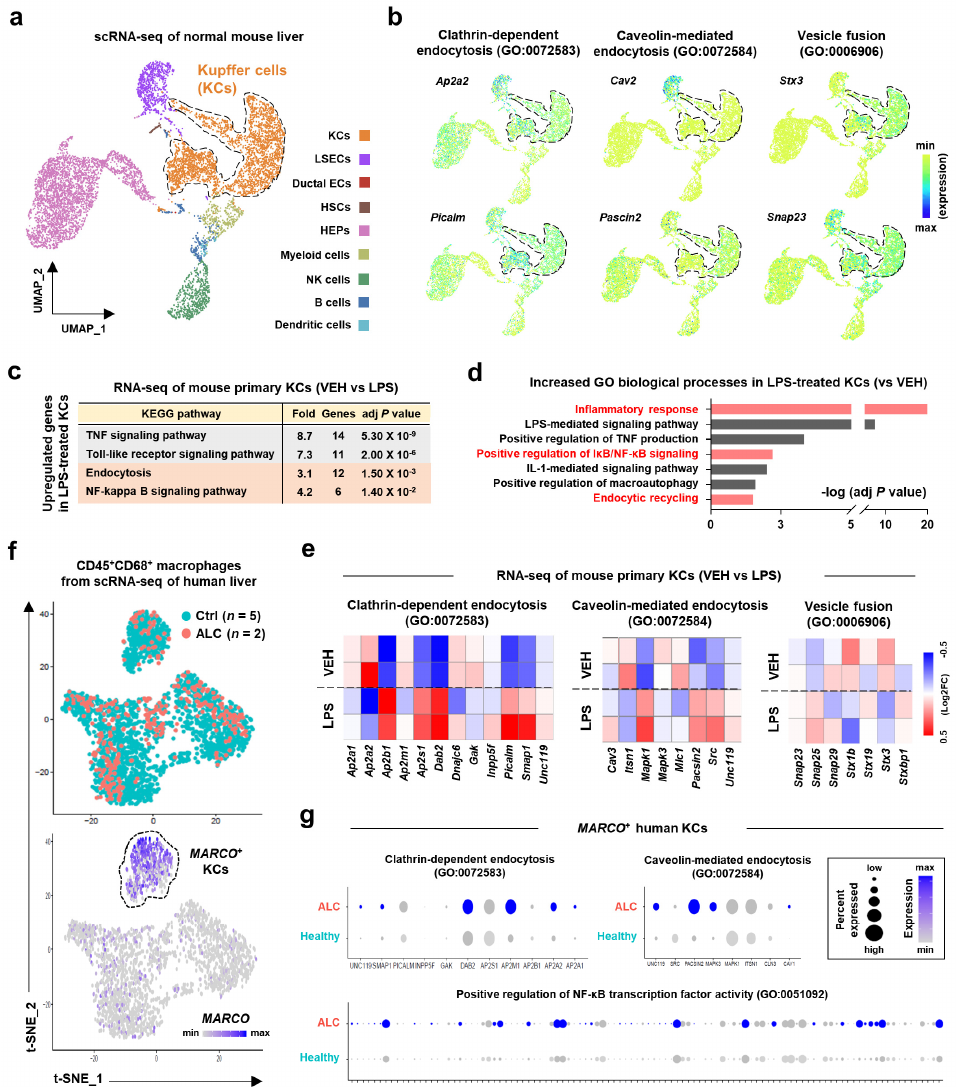
Figure 2. Increased expression levels of exosome uptake process-related genes in mice and human inflammatory Kupffer cells (KCs). ( a , b ) Single-cell RNA sequencing (scRNA-seq) of normal mouse liver (GSE132042) was analyzed. Uniform manifold approximation and projection (UMAP) presentation of feature plots for cell type annotation ( a ) or gene expression levels ( b ). ( c – e ) Bulk RNA-seq of mouse primary KCs (GSE86397) was analyzed. ( c ) Kyoto encyclopedia of genes and genomes (KEGG) pathway analysis of upregulated genes in lipopolysaccharide (LPS)-treated KCs. ( d ) In- creased gene ontology (GO) biological processes in LPS-treated KCs were analyzed. ( e ) Heatmaps showed relative expression levels of genes related to indicated pathways. ( f , g ) scRNA-seq of the human liver (GSE136103) from healthy control (Ctrl, n = 5) or patients with alcohol-associated liver